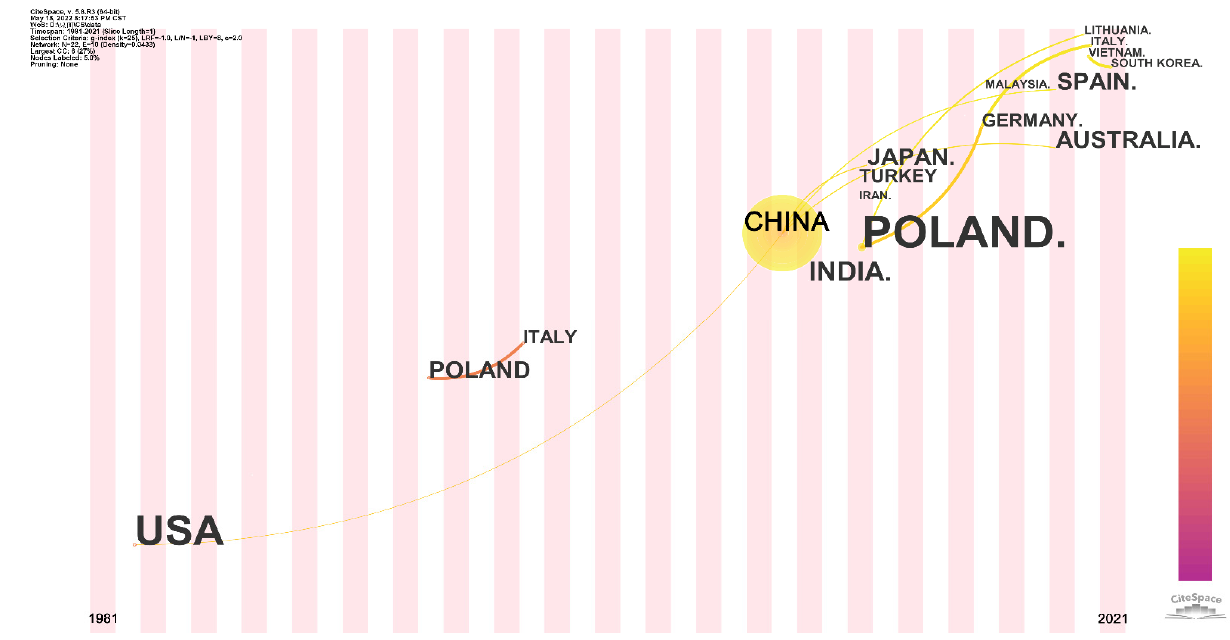
Figure 8. Time-zone view of geographic distribution for flame-retardant RPUF.